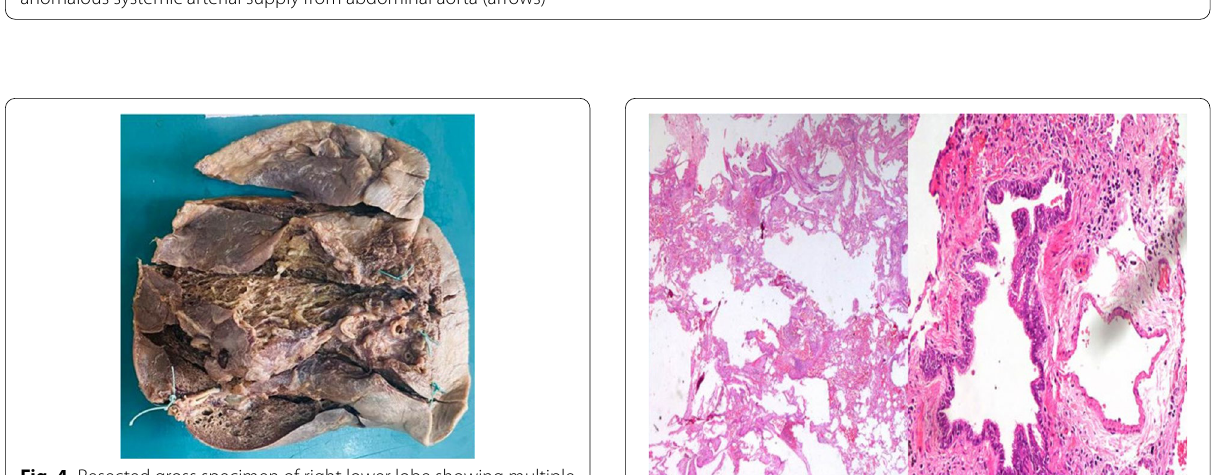
Fig. 3 A , B Axial lung and coronal oblique mediastinal window showing hypoattenuating lung lesion (*) with variable sized cystic areas showing anomalous systemic arterial supply from abdominal aorta (arrows)